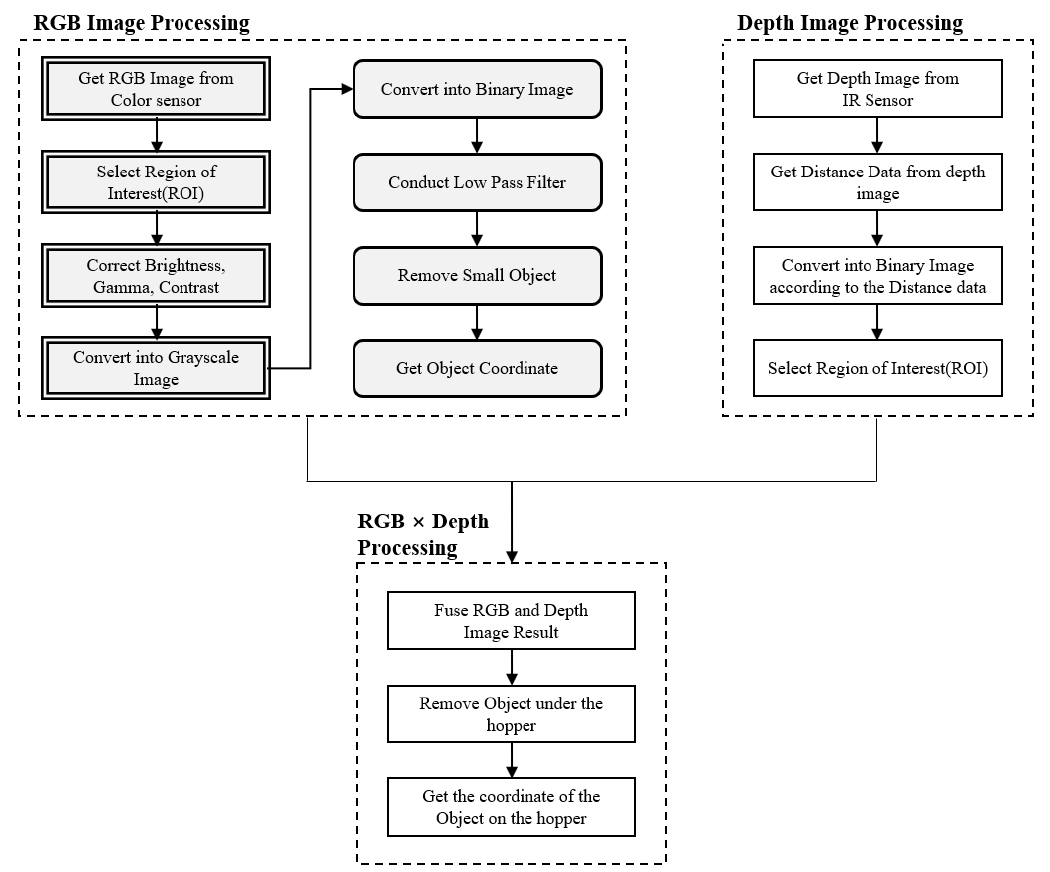
Figure 4. The procedure of machine vision-based processing of the RGB and depth images.